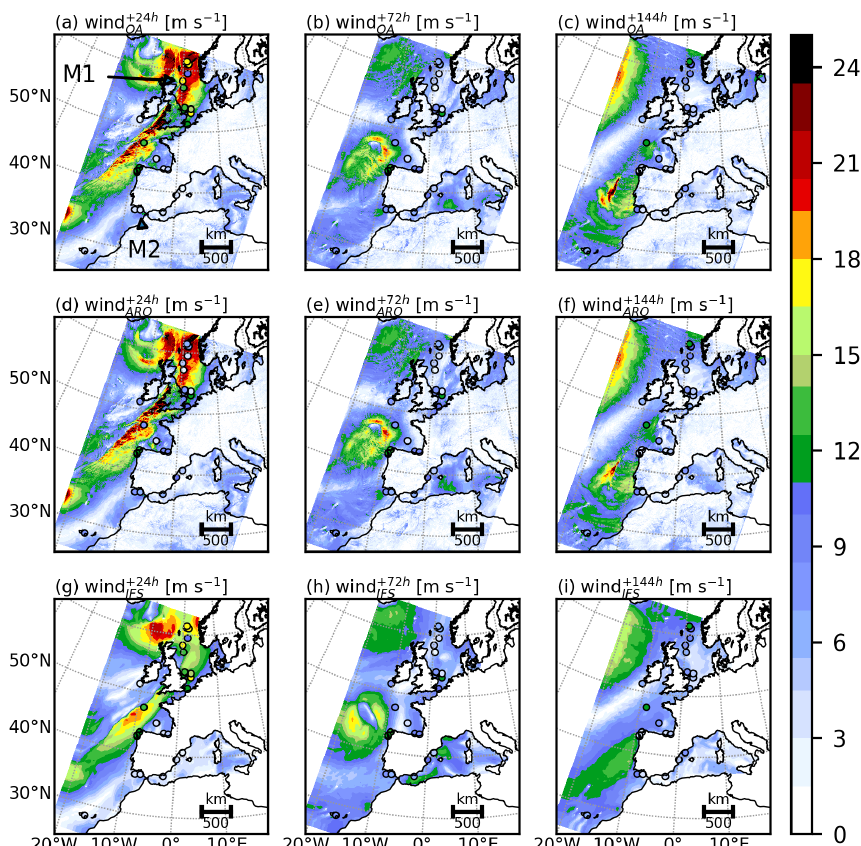
Figure 11. Instantaneous 10m ASL wind speed (ms − 1 ) simulated by OA (a, b, c), ARO (d, e, f) and IFS seen by OCE-ifs (g, h, i), for forecast ranges of (a, d, g) + 24h (13 October 2018, 00:00UTC), (b, e, h) + 72h (15 October 2018, 00:00UTC) and (c, f, i) + 144h (18 October 2018, 00:00UTC). The colour circles represent the wind speed measured by mooring buoys at that time; M1 and M2 labels in (a) indicate the location of the two mooring buoys used in Fig.